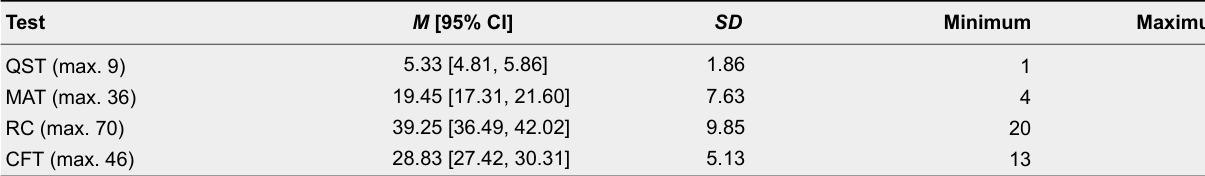
Descriptive Statistics for all Tests (N = 51)